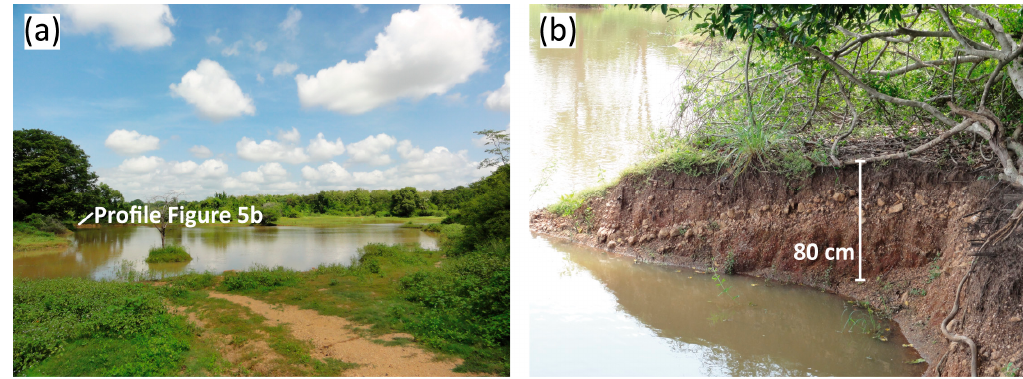
Figure 5. Photographs of tank 6, system 2 taken from the tank bund in October 2014. ( a ) The central part of the tank was illegally dredged; ( b ) c. 80 cm of sediments, or saprolite, were extracted. The deepening of the tank beds leads to the exposure of the regolith aquifer. Consequently, the tank bed does not desiccate in the dry period, resulting in a loss of pastures.